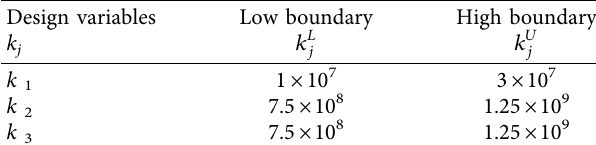
Table 3: Initial ranges of the design variables (unit: N/m).